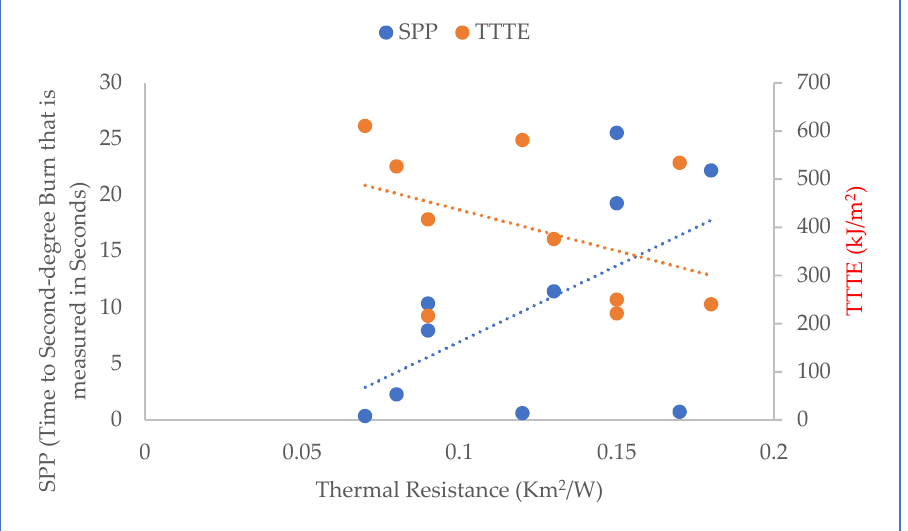
Figure 6. Relationship plot of thermal resistance with SPP and TTTE.